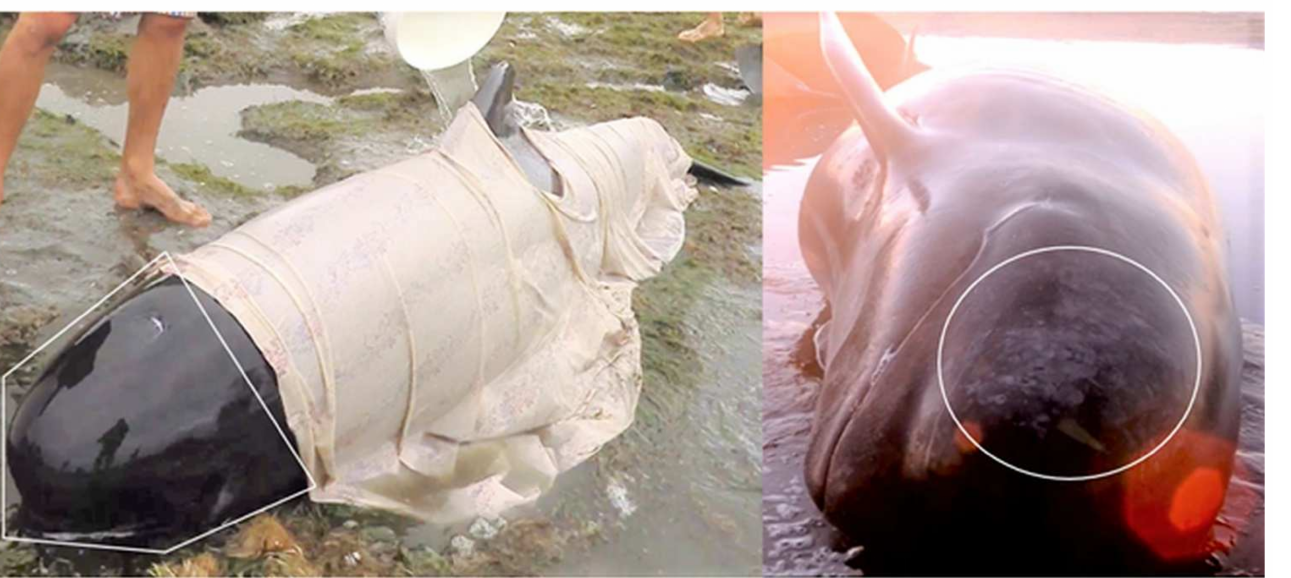
Figure 4. ( Left ): Observation of mucus from the blowhole and mouth of two live stranded long-finned pilot whales. Area considered the cranial region is defined within the white pentagon. ( Right ): Tattoo- like lesions (within white oval) observed on the cranial region of one individual. Photo credits: Kyle Mulinder ( Left ) and Project Jonah NZ ( Right